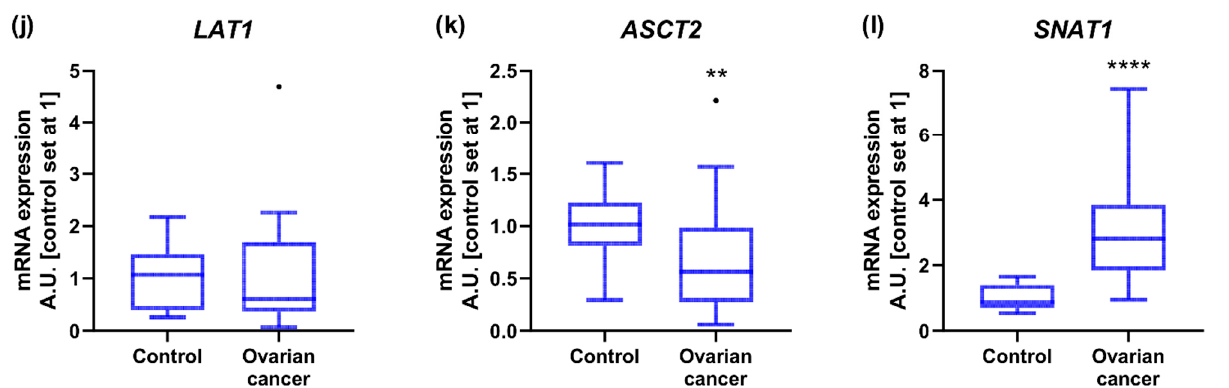
Figure 1. Transcript levels of ( a ) cluster of differentiation 36/a scavenger receptor class B protein, ( b ) membrane associated fatty acid binding protein, ( c ) fatty acid transport protein 1, ( d ) fatty acid transport protein 4, ( e ) fatty acid binding protein 4, ( f ) glucose transporter 1, ( g ) glucose transporter 4, ( h ) monocarboxylate transporter 1, ( i ) monocarboxylate transporter 4, ( j ) Na + -independent neutral amino acid transporter, ( k ) Na + -dependent neutral amino acid transporter and ( l ) Na + -coupled neutral amino acid transporter 1 in ovarian control (n = 14) and cancer tissue (n = 27). Measurements were made in duplicate, and arithmetic means were used for subsequent investigation. Results are expressed in arbitrary units with control set as 1 and presented as median (min to max)